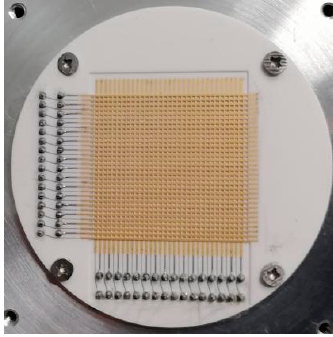
Figure 7. Photograph of XS anode. Table 1. Design parameters of XS anode.